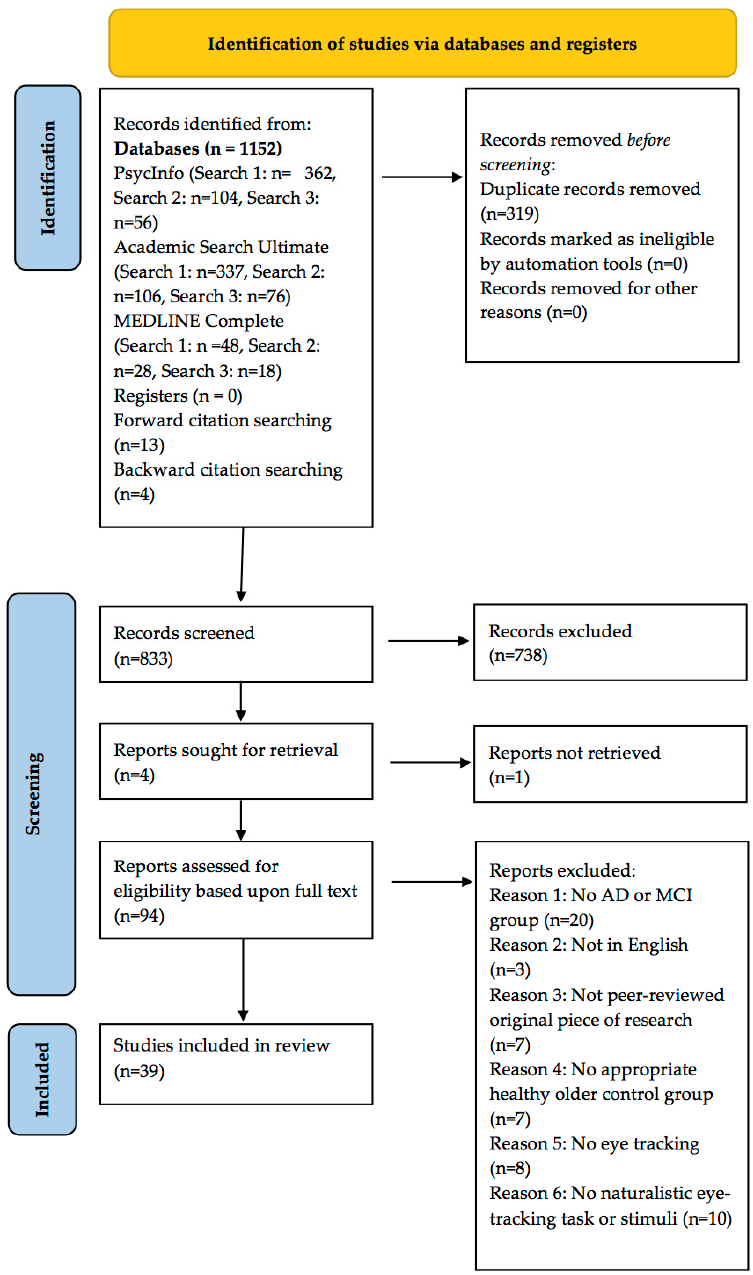
Figure 2. Modified PRISMA flowchart [52] detailing the number of records at each stage of the review. Note: Only the first reason for exclusion is reported for each paper (see Supplementary Materials for full reasons for exclusion for each paper). The PRISMA flowchart [56] allows for transparent reporting of our data collection, so that our searches can be